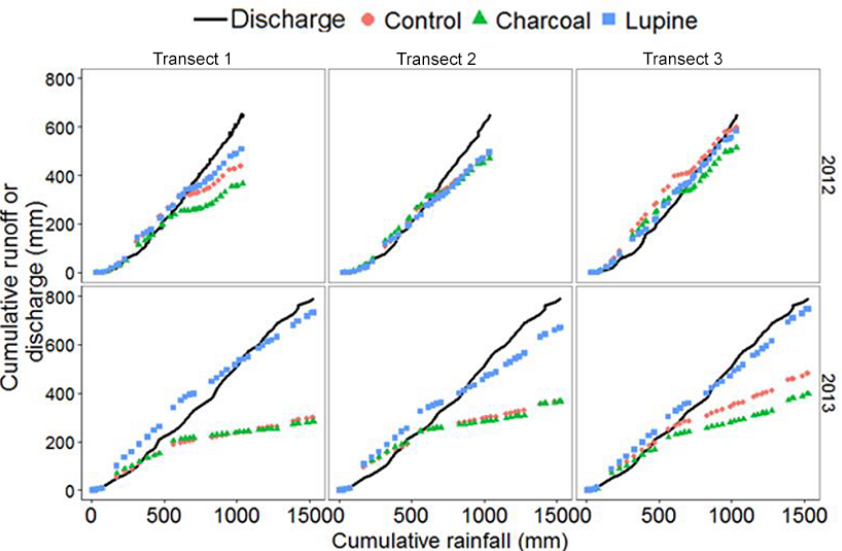
Figure 6. Cumulative rainfall vs. cumulative runoff (from control, charcoal, and lupine plots along three transects) and discharge at the watershed outlet, for 2012 and 2013.